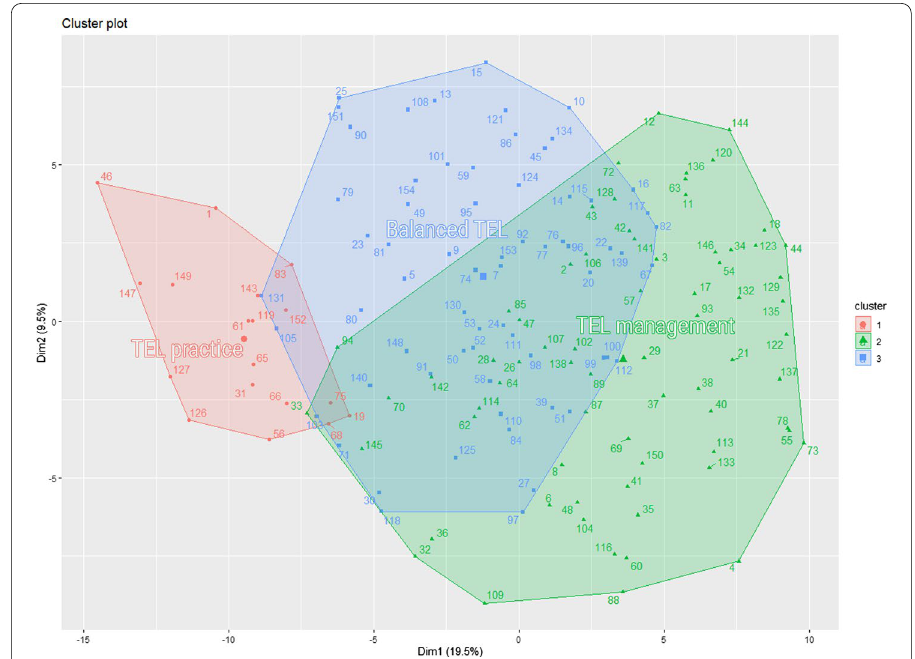
Fig. 5 Visualization of hierarchical cluster analysis of 154 study programs on